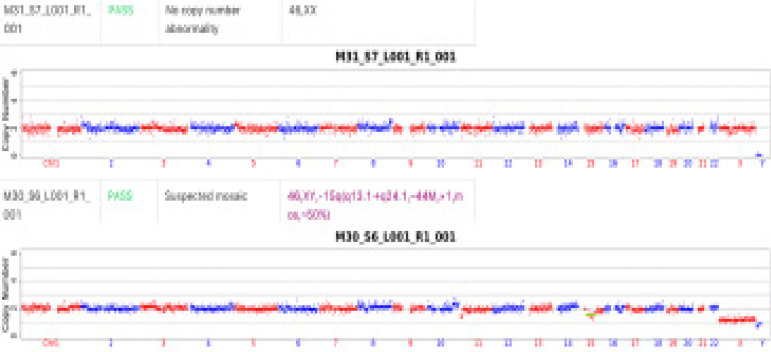
niPGT-A results